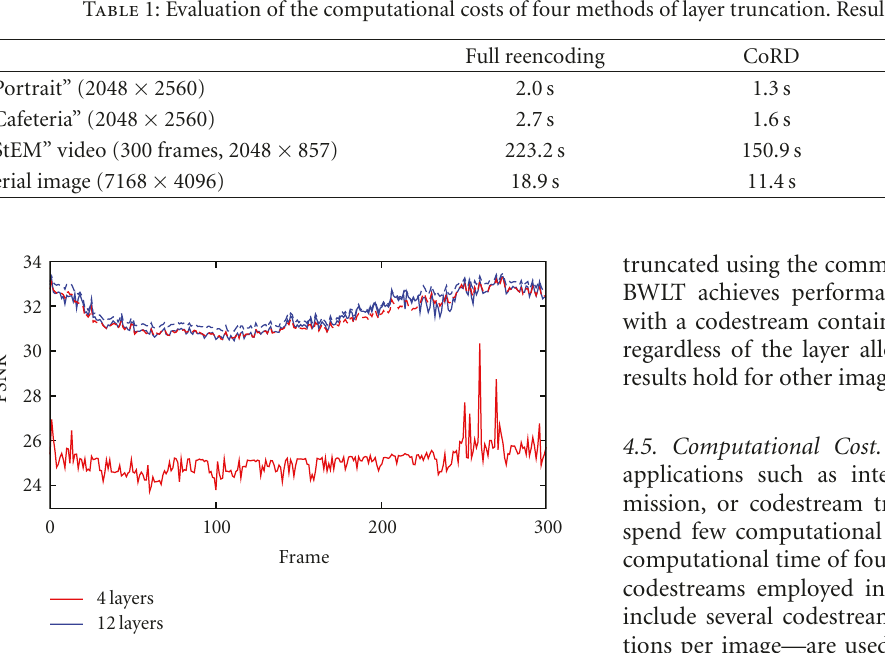
Figure 7: Performance evaluation of BWLT when applied to transmit a motion JPEG2000 sequence (dashed plot), compared to the common approach of layer truncation (solid plot). Results for the “StEM” video